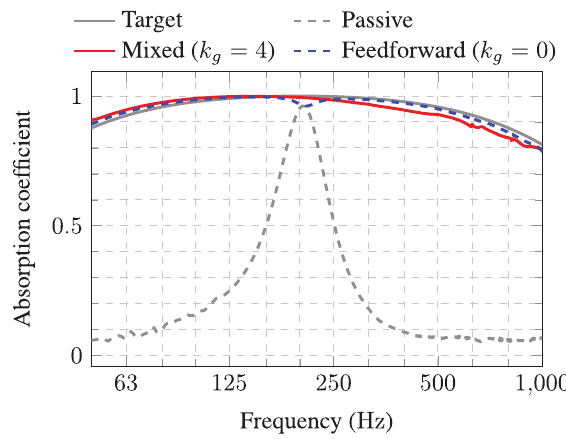
Figure 9. Experimentally obtained absorption coef fi cients for the broadband absorber, with